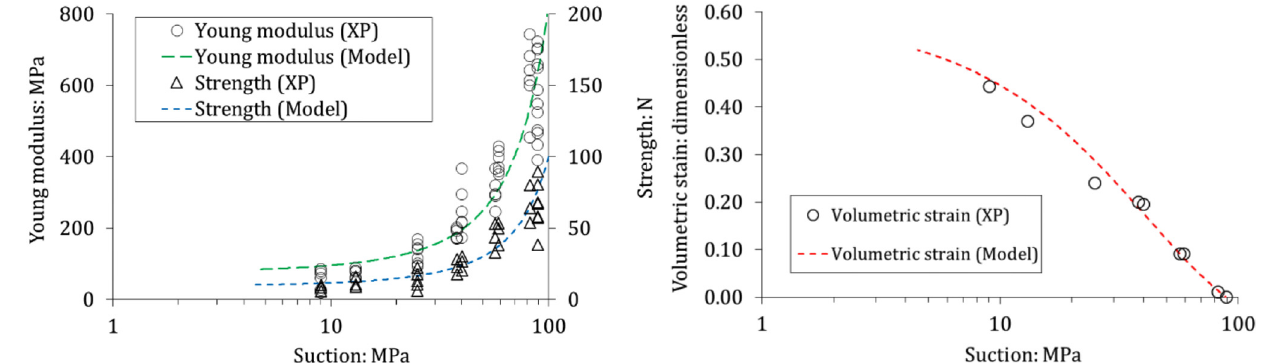
Fig. 2. Experimental results and model predictions: left, pellet Young modulus and strength and right, pellet volumetric strain [7].